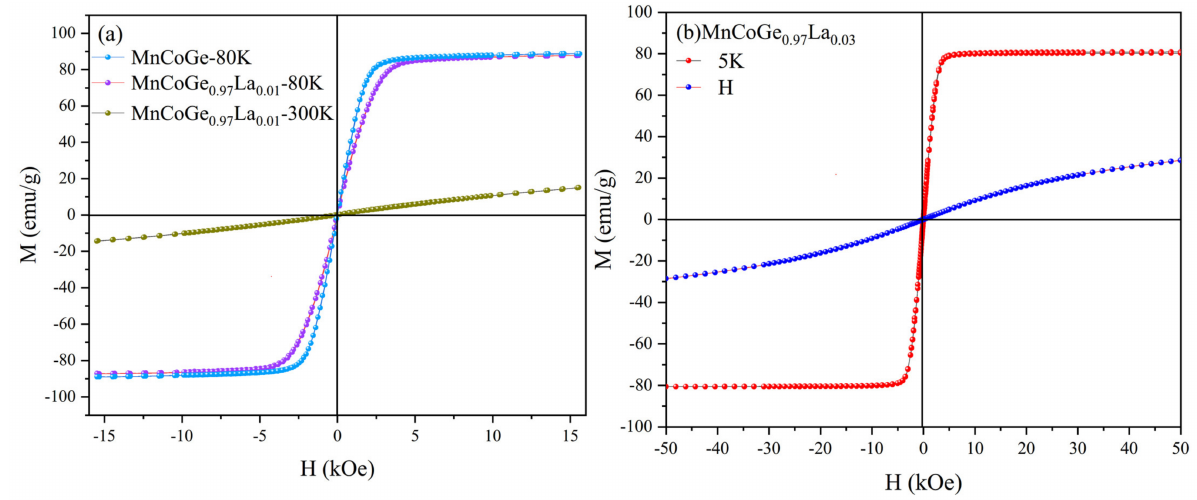
Figure 7. M-H curves of MnCoGe 1 − x La x measured at different temperatures: ( a ) MnCoGe and MnCoGe 0.99 La 0.01 ; ( b ) MnCoGe 0.97 La 0.03